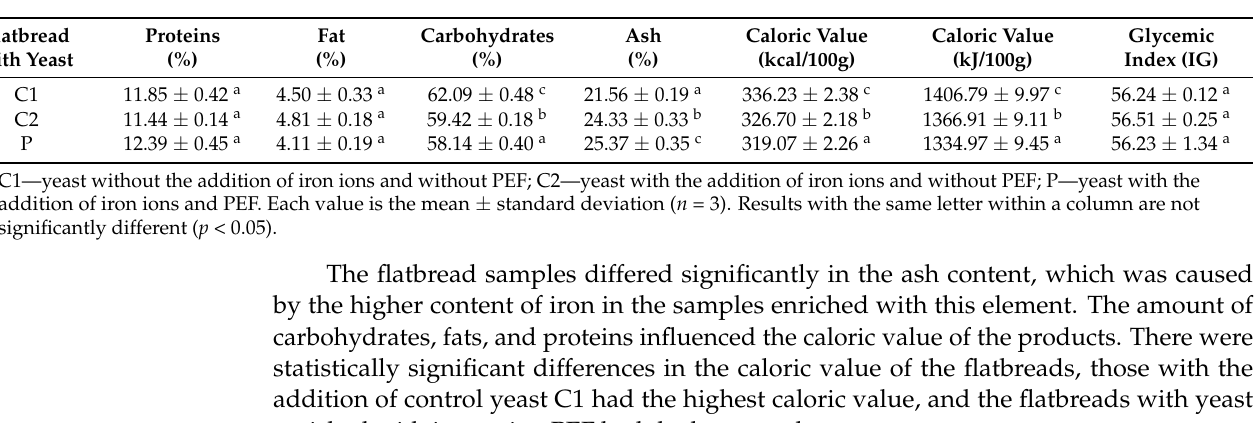
Table 1. Nutritional composition, caloric value, and glycemic index (GI) of flatbreads(content given on a dry mass) produced with yeast not enriched and enriched with iron